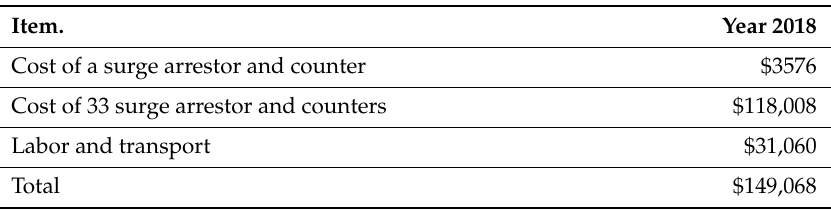
Figure 22. Break even cost of earthing enhancement with LSA vs. cost saving over a 10 years period. The 9.8 Ω protection profile sees a return of investment before the 6th year. The 18.8 Ω year profile sees a return of investment after the third year. The 29 and 34 Ω profile see a return of investment by the second year. Note the earthing cost is substantially reduced to obtaining higher earthing profiles. 4. Conclusions With the aid of earthing improvement methods, the TFR resistance from various values can be minimized and reduced. A reduction in TFR reduces the tower top voltage and would prevent the insulator voltage been exceeded. The cost of obtaining different earthing value for a suitable HVAC line length was estimated over 25 years. This cost varied significantly between a 4.9 Ω and a 34 Ω earthing profile. By maintaining a tower footing resistance value below 30 ohms, implies that the tower top voltage would be substantially reduced when compared with scenarios of having no earthing enhancements. The tower top voltage, when calculated by the developed MATLAB programs showed a reduction of almost 50%. This figure can be substantially higher should if lower tower footing resistance values are required, but at a substantially higher cost.